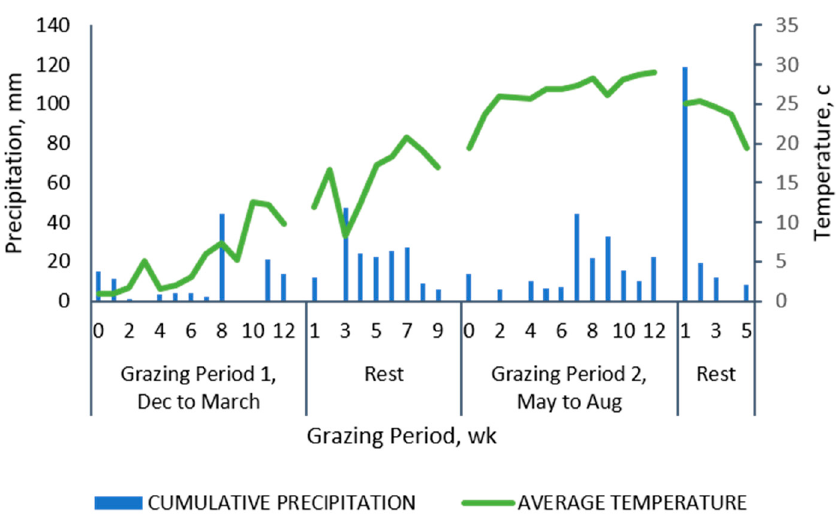
Figure 1. Cumulative precipitation and average temperature during the experimental period. Source: State climate office of North Carolina [27].